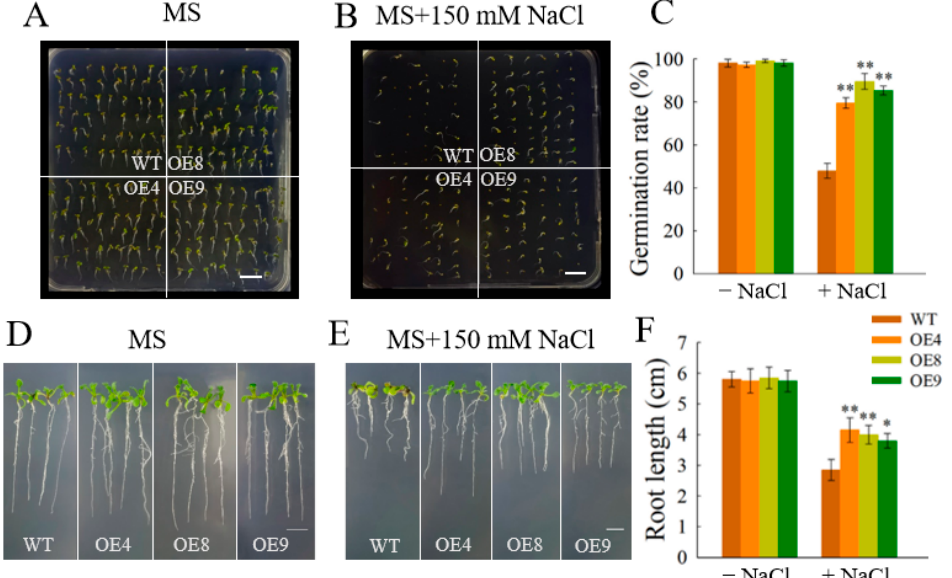
Figure 6. Seed germination and seedlings’ root length of OfSPL11 − overexpressed Arabidopsis . ( A , B ) seed germination phenotypes of Arabidopsis in MS medium containing different concentrations of NaCl; ( C ) germination rate of Arabidopsis seeds; ( D , E ) root phenotypes of Arabidopsis seedlings in MS medium containing different concentrations of NaCl. Scale bars = 1 cm; ( F ) root length of Arabidopsis seedlings. Each experiment had three biological replicates. * p < 0.05 and ** p < 0.01 were used to determine statistical significance.